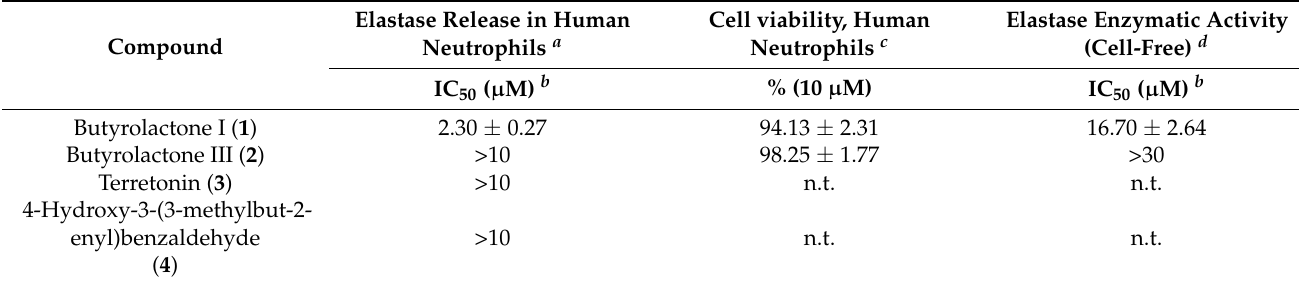
Table 2. Effects of the isolated compounds from the marine-derived fungus Aspergillus terreus on elastase release, viability, and elastase enzymatic activity in vitro.